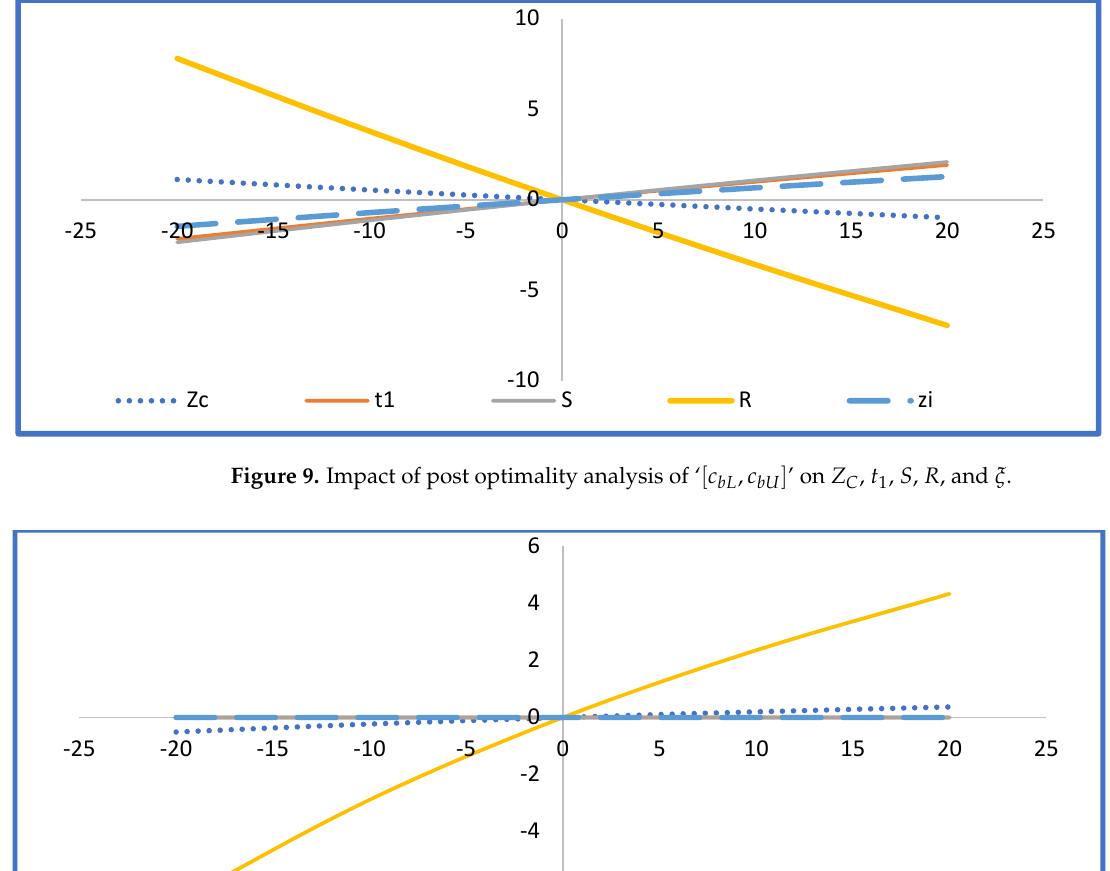
Figure 8. Impact of post optimality analysis of ‘ a 2 ’ on Z C , t 1 , S , R , and ξ .